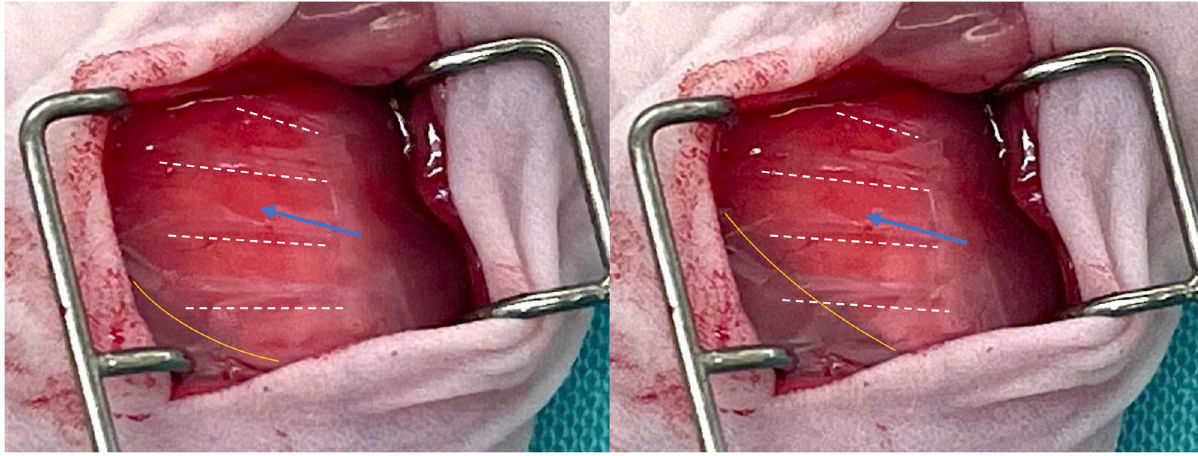
Fig 1. Image of the incision site featuring the lung visible through the chest wall. Images show a lung on exhale (left) and inhale (right). Relevant anatomical landmarks such as the ribs (white dashed lines), lower border of the lung (orange line) and the third intercostal space (blue arrow) counting from the lowest true rib towards the cranial direction are